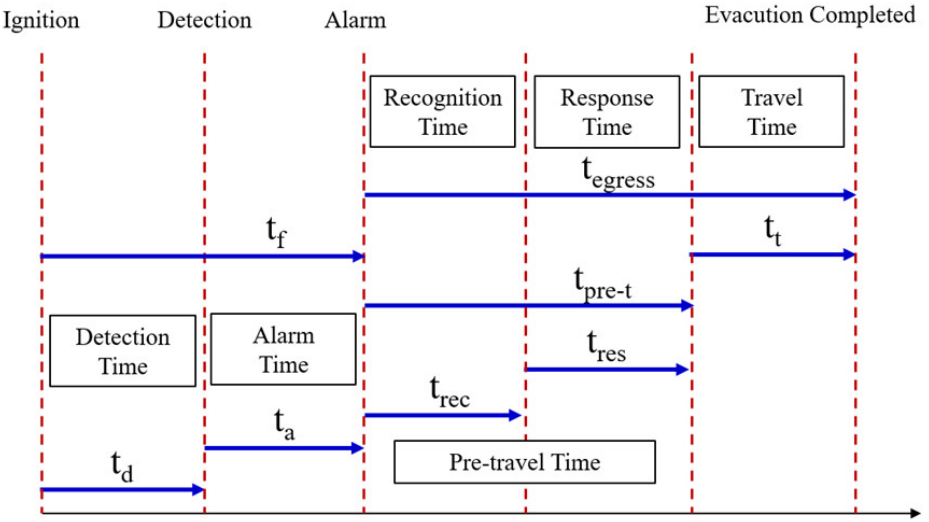
Figure 2. Flow chart of timed egress analysis method.